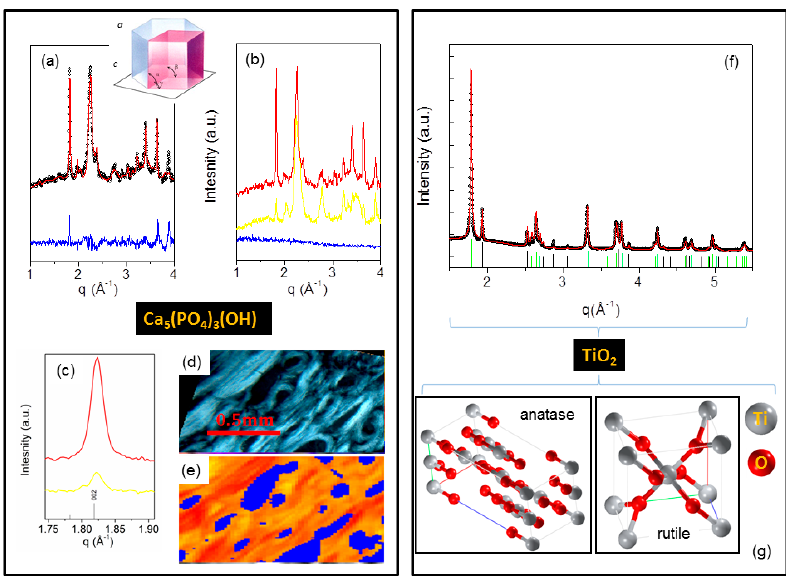
Figure 7. ( a ) X-ray powder diffraction profiles hexagonal hydroxyapatite nanocrystals measured from healthy and pathologic human bone sections. Dotted curves are the experimental data, red lines the fitted profiles. Experiments were performed at the cSAXS beamline of the SLS synchrotron source, in transmission scanning mode with λ = 0.6673 Å; ( b ) blue line is the background profile, red and yellow ones correspond to the same hydroxyapatite (HA) crystal structure as in (a), with/without (red/yellow) preferred orientation; ( c ) zoom of the (002) reflection from the whole patterns in (b); ( d ) Light microscopy of the same sample in (a); ( e ) scanning WAXS microscopy of the same sample in (a); ( f ) X-ray powder diffraction profile measured from a powder mixture of anatase and rutile nanocrystals. Dotted curve is the experimental data, red line the fitted profile. Experiments are performed with a Bruker D8-Discover diffractometer, in reflection mode, with Cu K α 1 radiation, i.e., λ = 1.540562 Å. ( g ) anatase and rutile crystal structures. Partially reprinted with permission from reference [62].